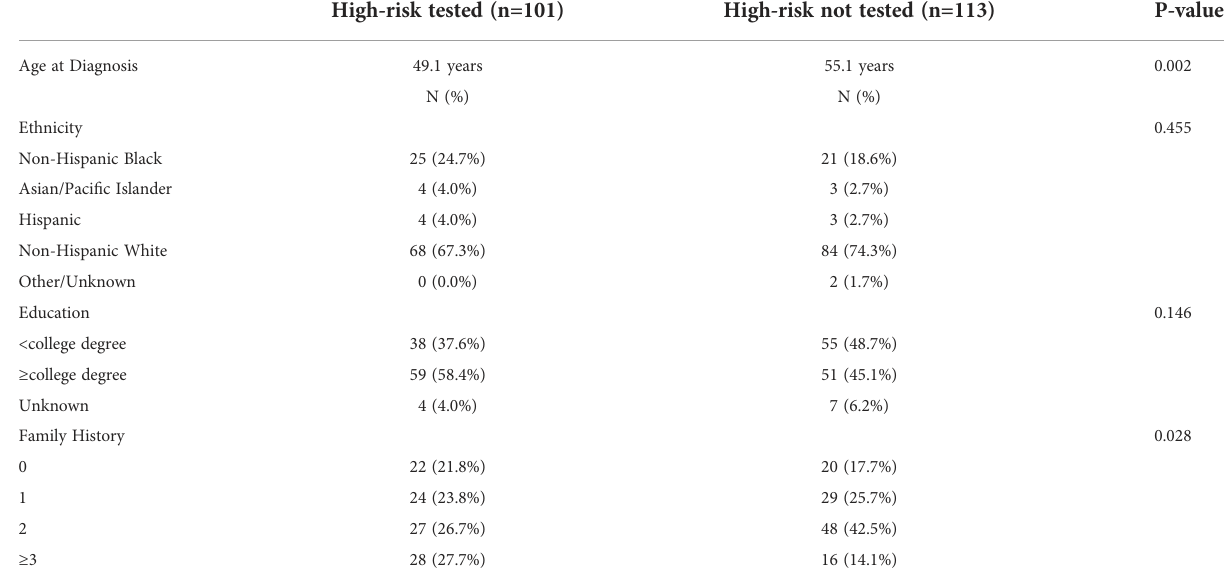
TABLE 2 Demographic and clinical information for patients classi fi ed as test eligible at the time of diagnosis who did or did not pursue genetic testing. High-risk tested